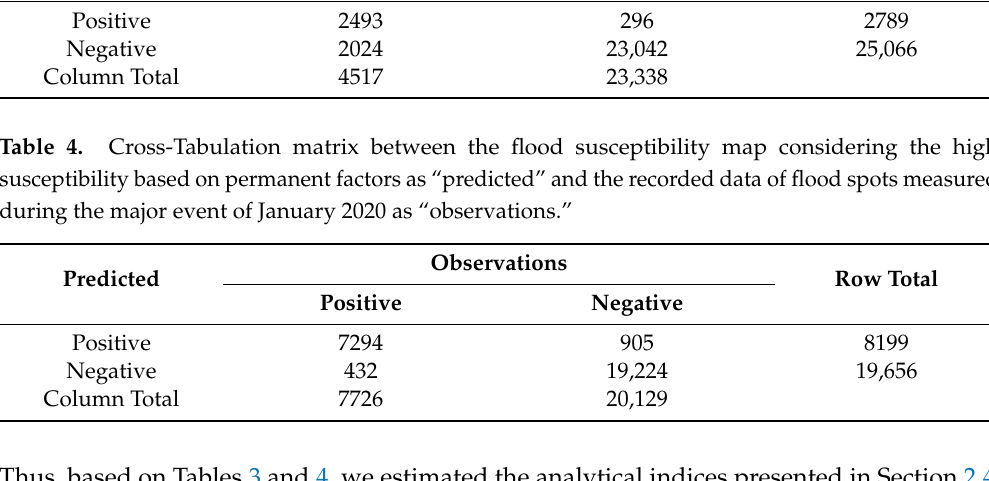
major event of January 2020 as “observations.”